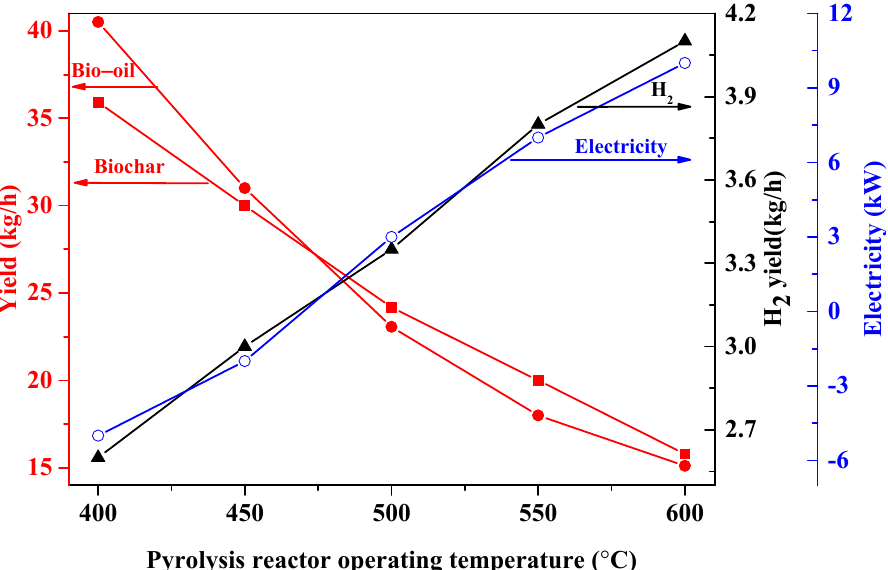
Figure 3. Influence of the pyrolysis reactor operating temperature on hydrogen, biochar, bio-oil and electricity production. The temperature of steam reactor and air reactor are kept at 700 and 980 °C.